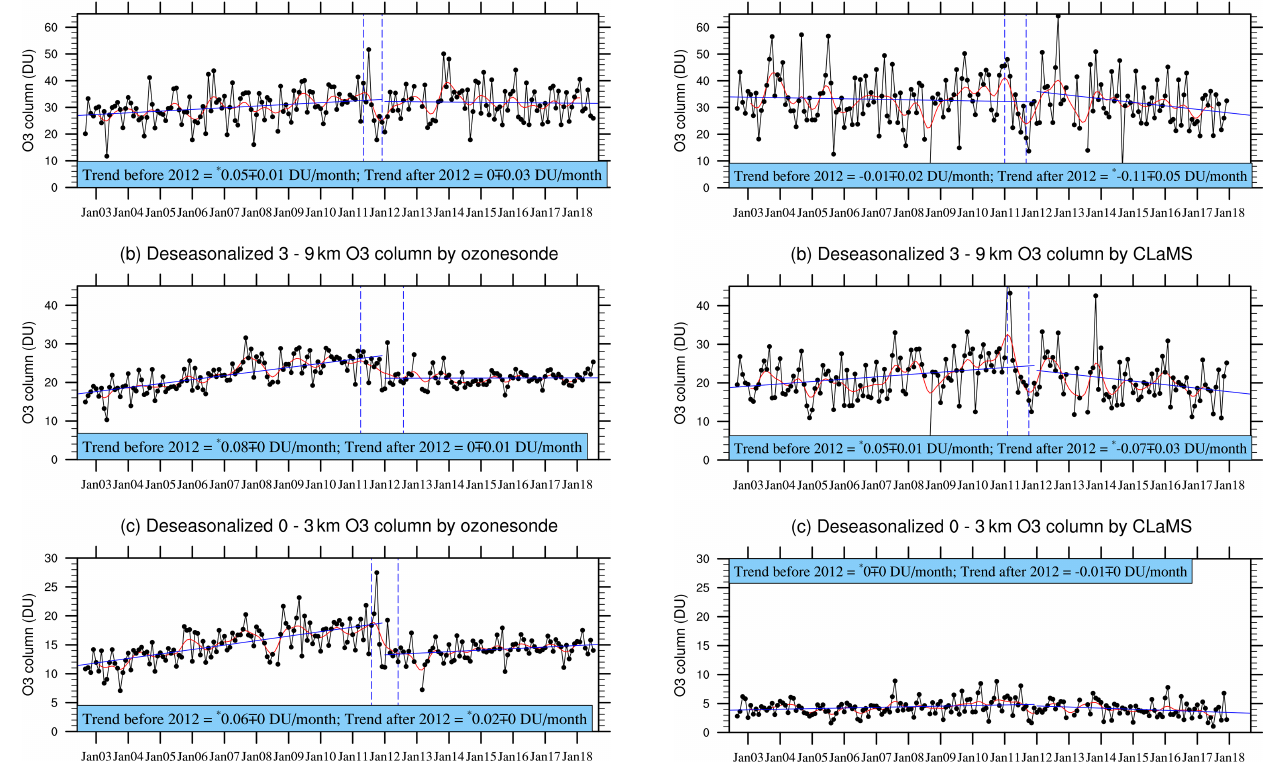
Figure 4. Deseasonalized monthly mean partial columns of ozone over Beijing (solid black lines and dots) simulated by CLaMS and the corresponding Gaussian-weighted means using a half-width of 12 months (red curves). The solid blue lines estimate the linear trends (slope ∓ standard error) before and after the decrease in ozone during late 2011 and early 2012. The periods of decrease are represented by the time between the two dashed blue lines. The trends with “*” passed the 95% significance criterion.